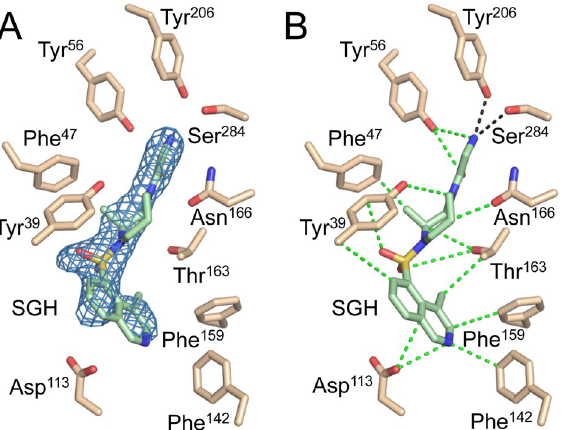
Figure 7. EgtD-SGH interactions. ( A ) The composite omit 2Fo-Fc map for the ligand contoured to 0.9 σ. ( B ) The various protein–ligand interactions that contribute to SGH binding are shown with van der Waals interactions in green dashed bonds and polar interactions with the Histidine binding site residues Tyr 206 and Ser 284 in black dashed bonds.